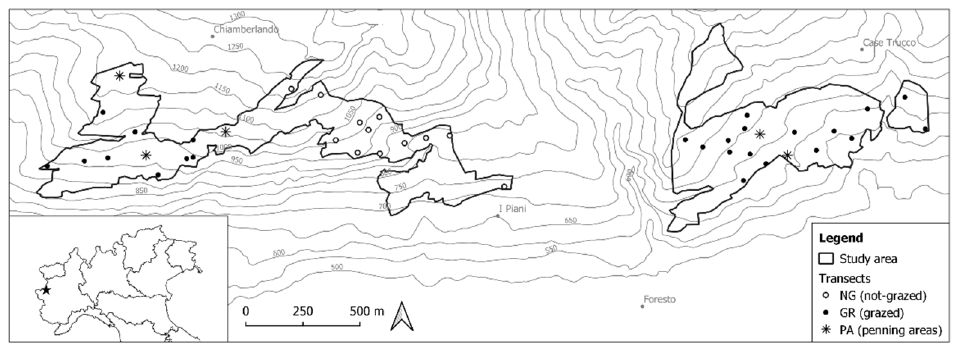
Figure 1. Map of the study area in the Western Italian Alps and location of the permanent transects. Each penning area (PA) includes five permanent transects.